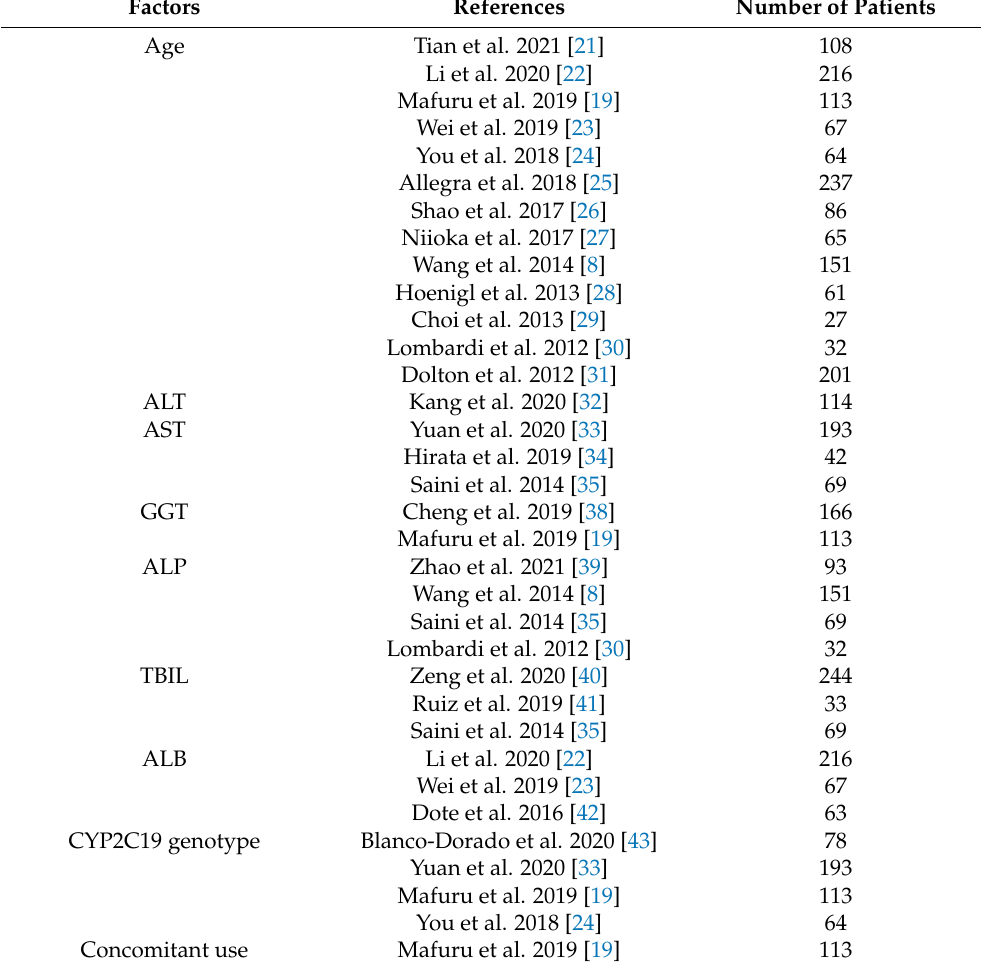
Table 5. Factors affecting voriconazole